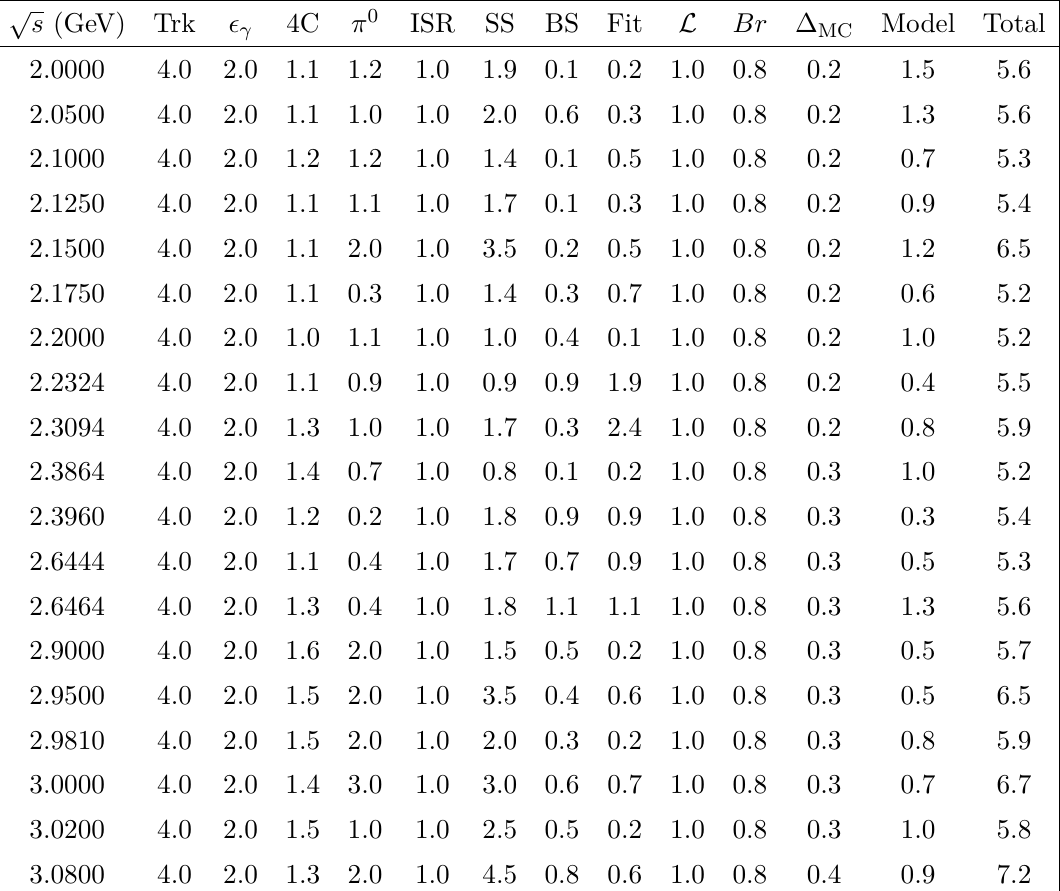
Table 6 . Systematic uncertainties (in unit of % ) of the e + e − → ωπ + π − cross section measurements √ at various energy points ( s ). The main sources are from track efficiency (Trk), photon detection efficiency ( (cid:15) ), 4C kinematic fit (4C), π 0 mass window ( π 0 ), ISR effect, signal shape (SS) and back- γ ground shape (BS), fit range (Fit), luminosity measurement ( L ), ω decay branching fraction ( Br ), MC statistics ( ∆ ), and MC model. Meanwhile, the total uncertainty for each point (Total) is MC obtained by summing the individual contributions in